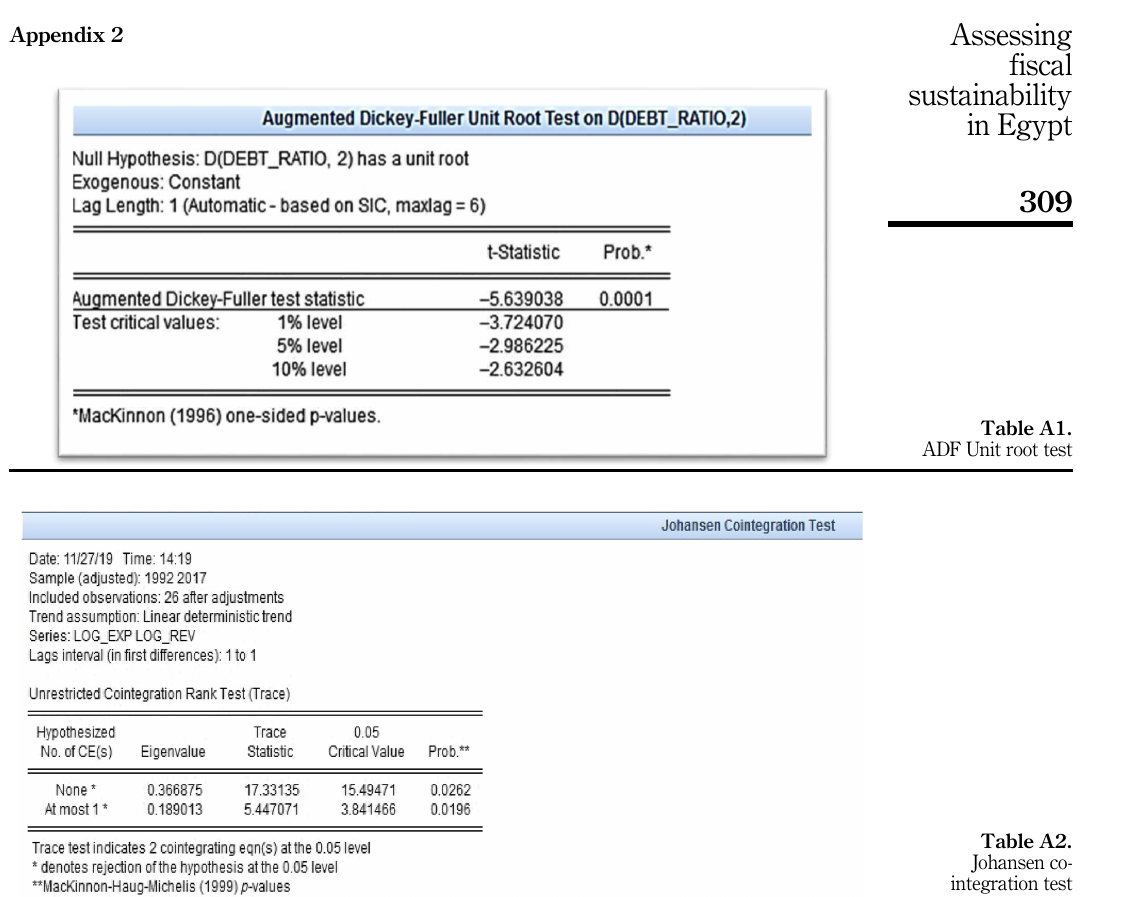
Table A2. Johansen co-